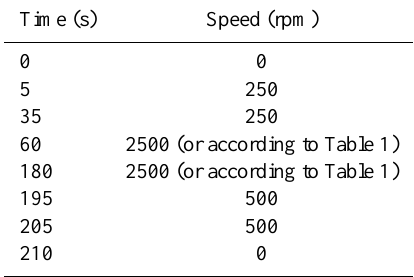
Table A1. Speed profile for spin-coating.